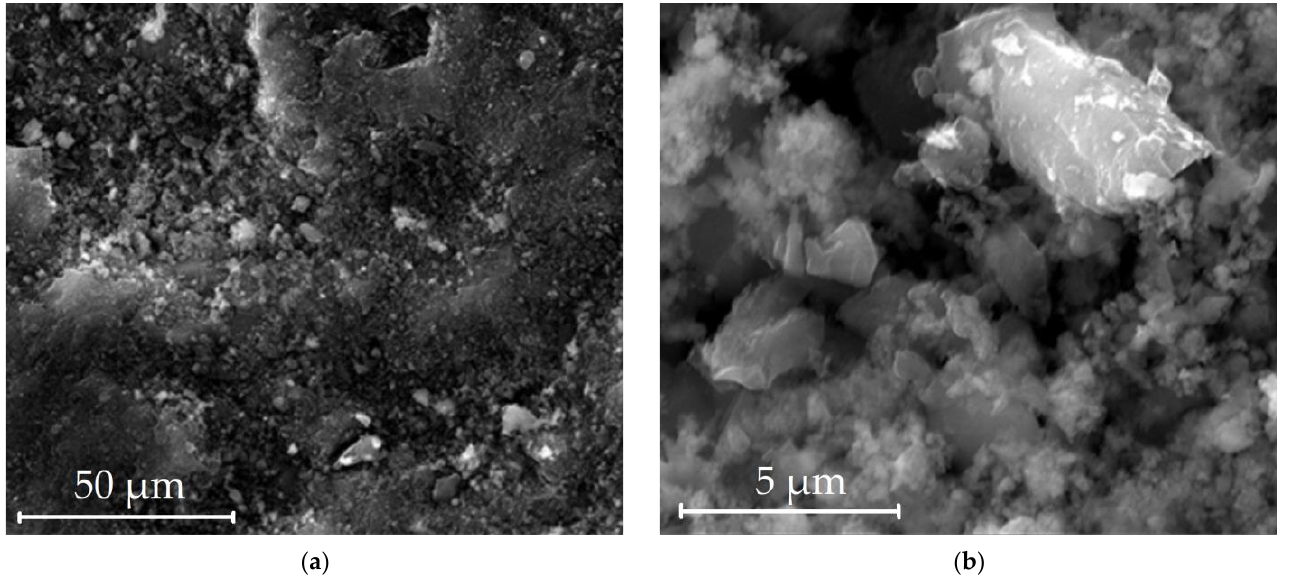
Figure 4. Electron microscopy images of the surface of the adsorbent from peat raw material ACPK: 50 µm ( a ); 5 µm ( b ). Table 2. Elemental chemical composition of the ACPK surface.